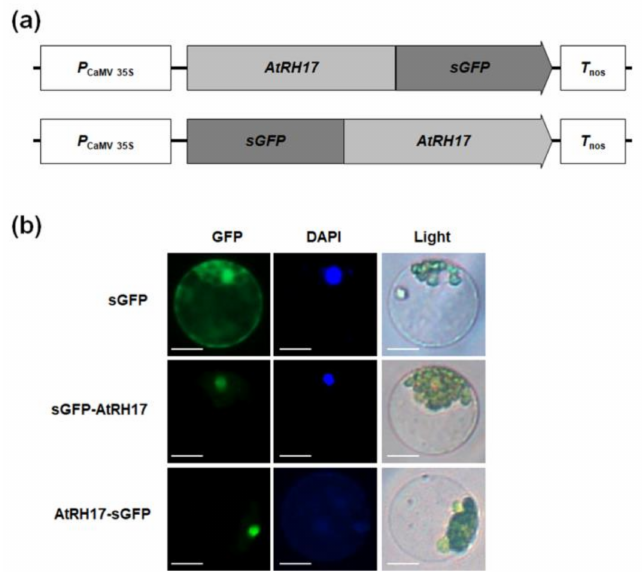
Figure 3. Investigation of the subcellular localization of AtRH17 in Arabidopsis protoplasts. ( a ) Schematic maps of the entire ORF of AtRH17 constructs fused to C-terminal or N-terminal synthetic green fluorescent protein (sGFP). ( b ) The subcellular localization of AtRH17 protein was examined by transient expression in Arabidopsis protoplasts. Left, GFP signal; middle, 4 (cid:48) ,6-diamidino-2-phenylindole (DAPI) staining; right, light microscopic picture. Scale bars represent 10 µ